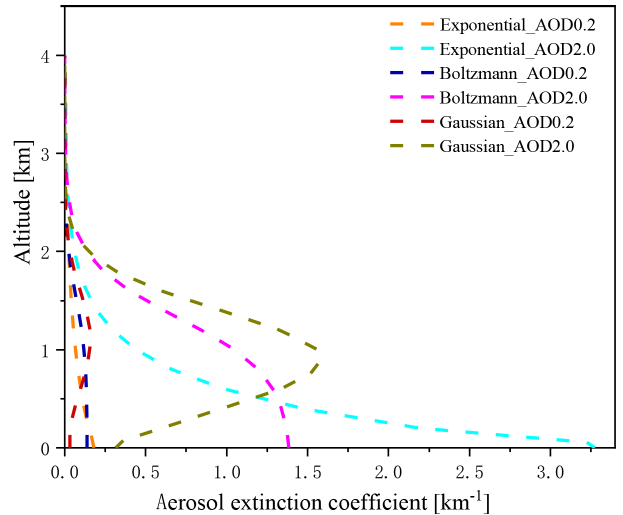
Figure 3. Different aerosol a priori profiles used by PriAM in this study.